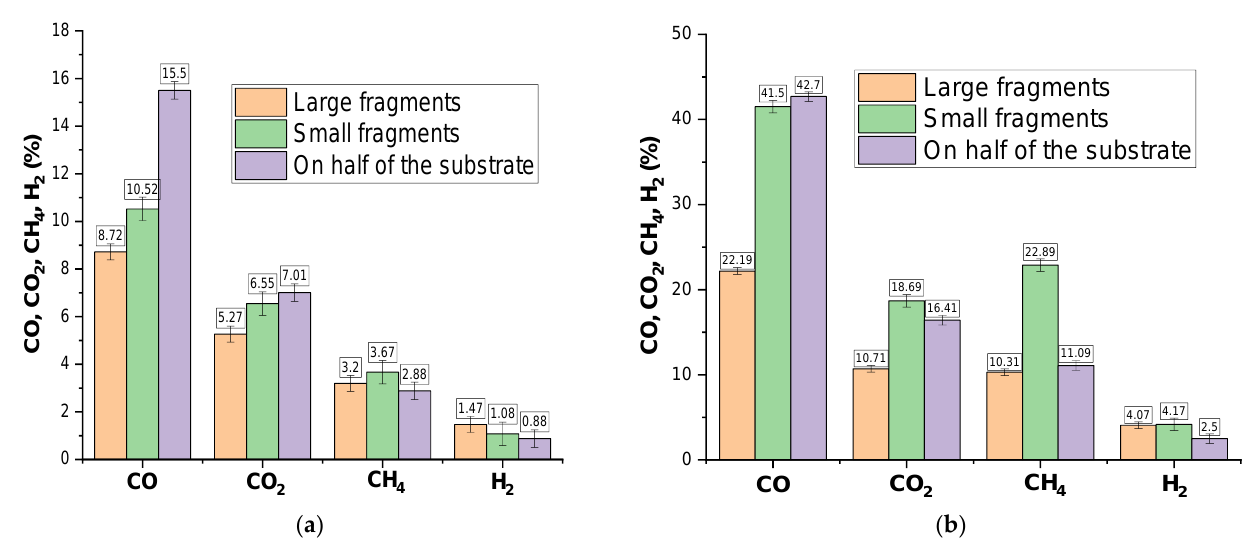
Figure 9. Average ( a ) and maximum ( b ) values of the concentrations of the gas mixture components when varying the fuel distribution in the crucible.